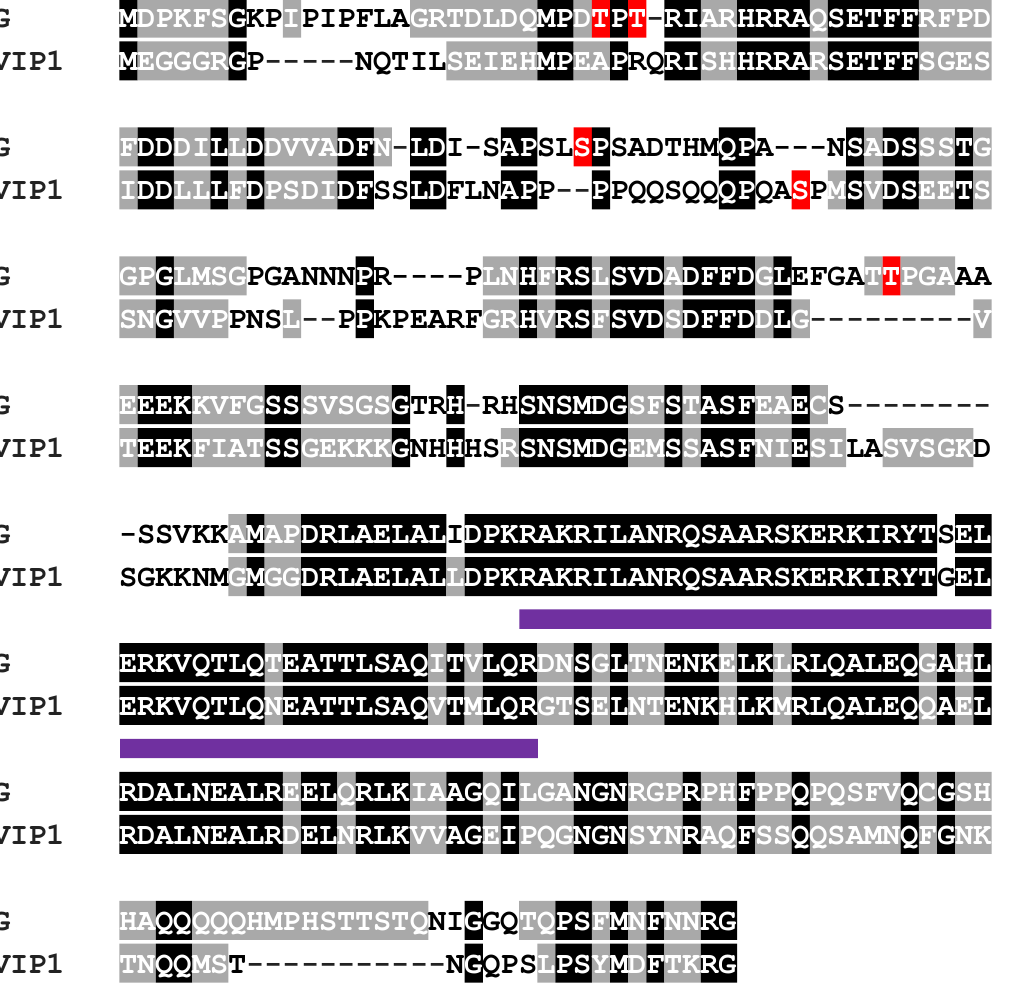
Figure 1. Amino acid sequence alignment of RSG and AtVIP1. The RSG from N. tabacum cv. Turk (accession number BAA97100.1) was aligned using the T-Coffee program (http://www.ebi.ac.uk/ Tools/t-coffee/index.html, accessed on 25 June 2022) with its closest homolog AtVIP1 from Arabidopsis Figure 1 . Amino acid sequence alignment of RSG and AtVIP1. The RSG from N. tabacum thaliana (AtVIP1, accession number NP_564486.1). Amino acid residues identical between RSG and AtVIP1 are highlighted in black and gray for conserved hits. The basic leucine zipper (bZIP) domains are underlined in purple. Amino acids potentially phosphorylated by MAPK are highlighted in